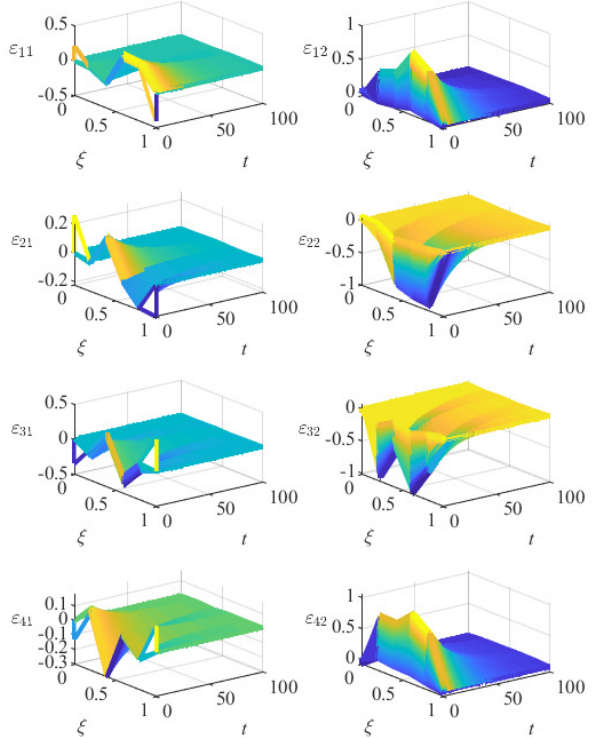
Figure 2. ε i ( ξ , t ) with the control gains d = 0.51 and k = 0.01 in Example 1.